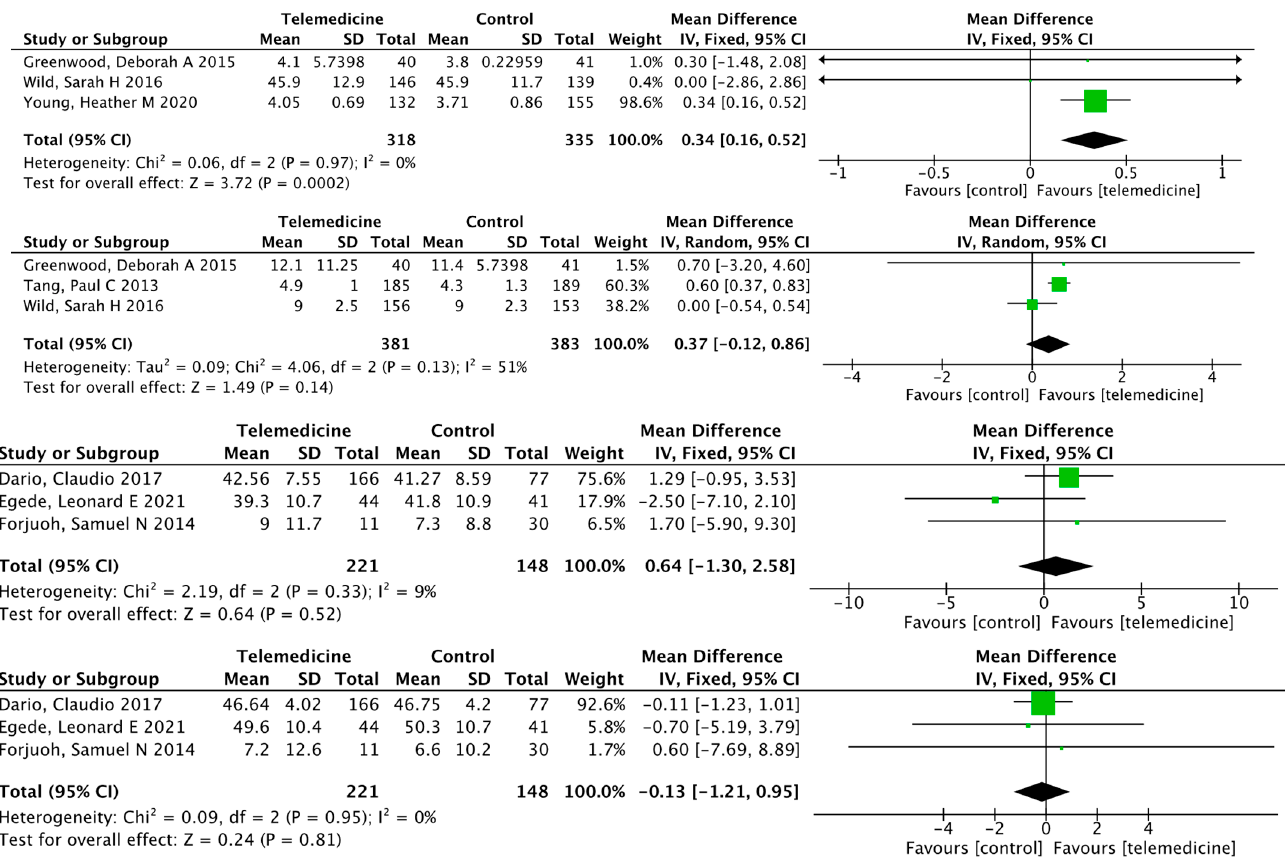
Figure 11. Mean difference in the changes in self-efficacy, diabetes knowledge, physical health, and mental health levels for telemedicine and usual care interventions.